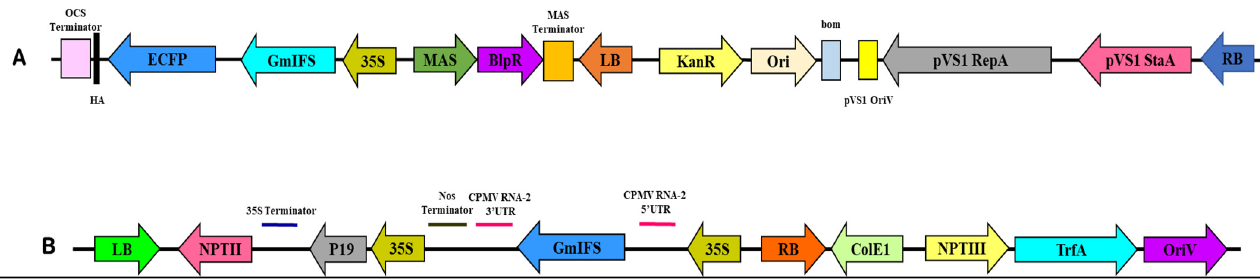
Figure 3. Diagrammatic representation of the gateway destination vectors ( A ) pEarleyGate102 HA and ( B ) pEAQ-HT-DEST 3 used in the study. ( A ) LB and RB: The right and left borders of the T-DNA region in Agrobacterium ; MAS terminator: